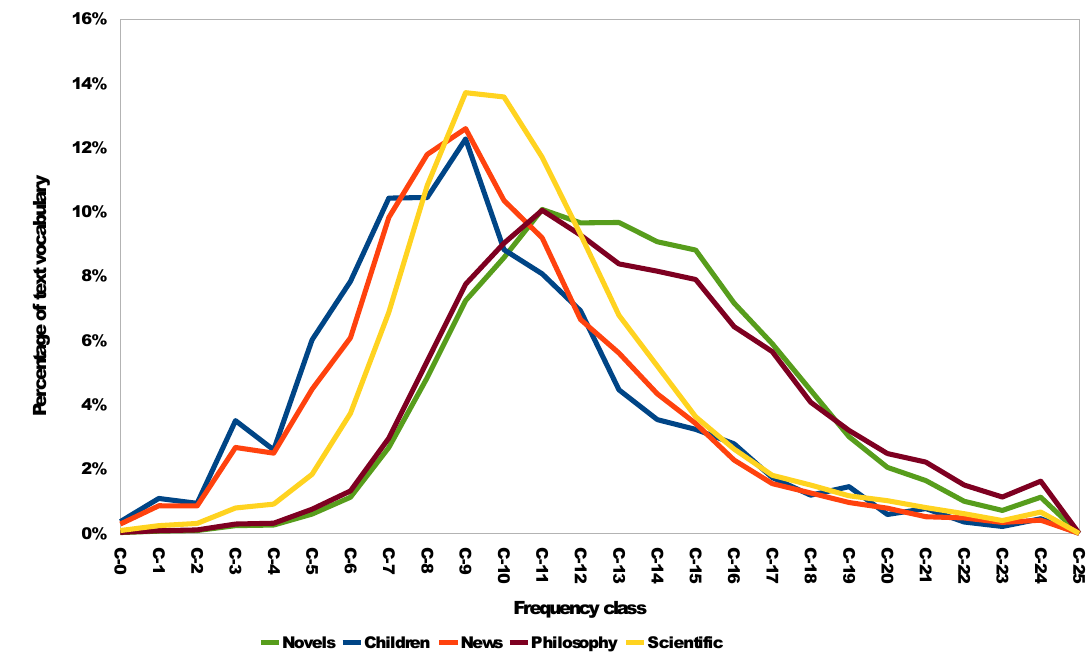
Figure 2. Distribution of terms in frequency classes for different types of texts.